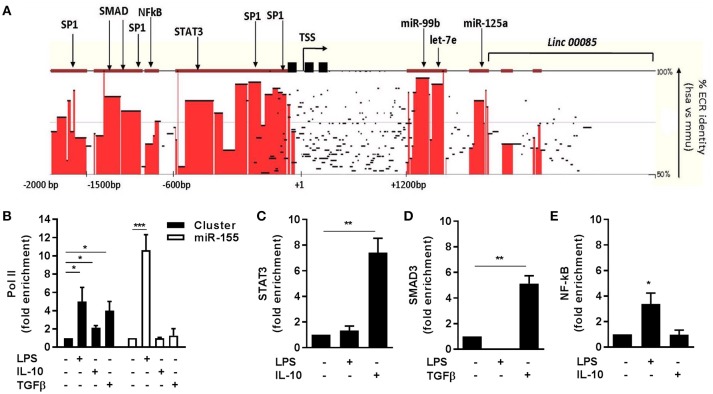
Transcriptional regulation of miR-125a~99b~let-7e cluster. (A) Sequence homology between human (chr.19: 52191745-52196592) and murine (chr. 17:17827604-17832451) miR-125a~99b~let-7e loci was analyzed by pairwise sequence local alignment using the TBA alignment program and visualized as a conservation plot generated by the Mulan software. Red blocks identify evolutionary conserved regions (ECR) with >50% identity between the two species over 100 bp segments. The transcription start site (TSS), TATA boxes (black squares), and the putative binding sites for transcription factors are indicated. (B–E) ChIP assays were carried out on human monocytes stimulated or not for 4 h with 25 ng/ml IL-10, 100 ng/ml LPS or 50 ng/ml TGFβ using anti-Pol II (B) Abs or for 12 h with anti-STAT3 (C), anti-SMAD3 (D), or anti-NF-kB (E) antibodies. Q-PCR was carried out using specific primers for the miR-125a~99b~let-7e promoter (black columns in panels B–E) or the miR-155 promoter (white columns in panel B). Results are expressed as fold change over control (mean ± SEM; n = 3). (* < 0.05; ** < 0.01; *** < 0.001).